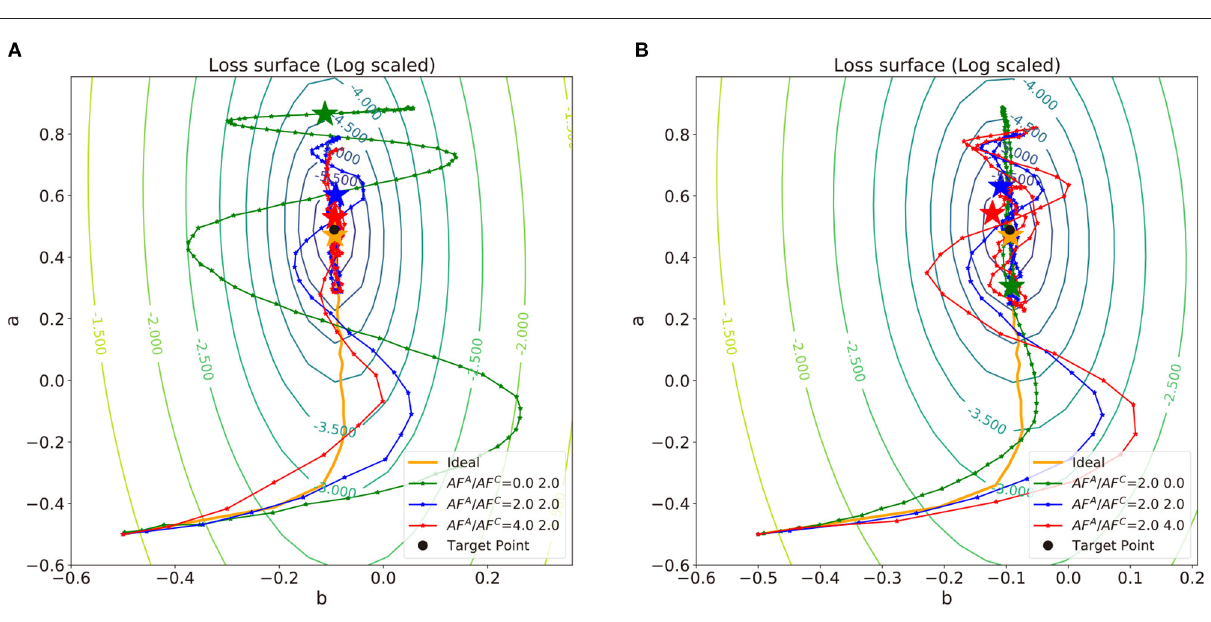
FIGURE 5 | Trajectories of weights in the log-scaled loss surface for convex problem where the data is sampled from the same distribution as described in Figure 4A and the normalized schedulers, t ( k ), of a variable b described in Figure 4A . (A) AF C is fixed with 2.0 and (B) AF A is fixed with 2.0. The points of each trajectory are marked for every